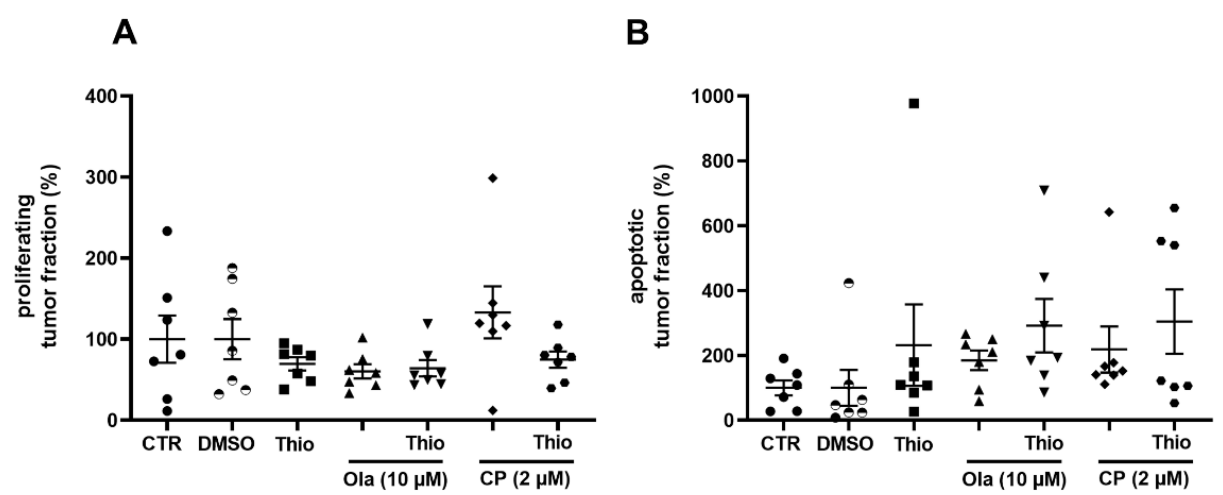
Figure 3. FOXM1- and PARP- inhibitor and carboplatin as mono- and combined therapy. Tissue was treated with thiostrepton (Thio), olaparib (Ola) and carboplatin (CP). To investigate the beneficial effect of FOXM1 inhibition, olaparib and carboplatin were combined with thiostrepton. DMSO is the vehicle control for all conditions except carboplatin. Conditions were normalized to their control, respectively. All drugs were applied for 72 h after 24 h from the start of cultivation. ( A ) Effect of all treatment conditions on tumor proliferation. Tissue was stained for Ki67, panCK and Hoechst to determine tumor proliferation. n = 7 ( B ) Effect of all treatment conditions on tumor apoptosis. Tissue was stained for cleaved PARP, panCK and Hoechst to determine tumor apoptosis. n = 7; error bars represent SEM. One-way ANOVA ( p < 0.05) showed no significant alterations.